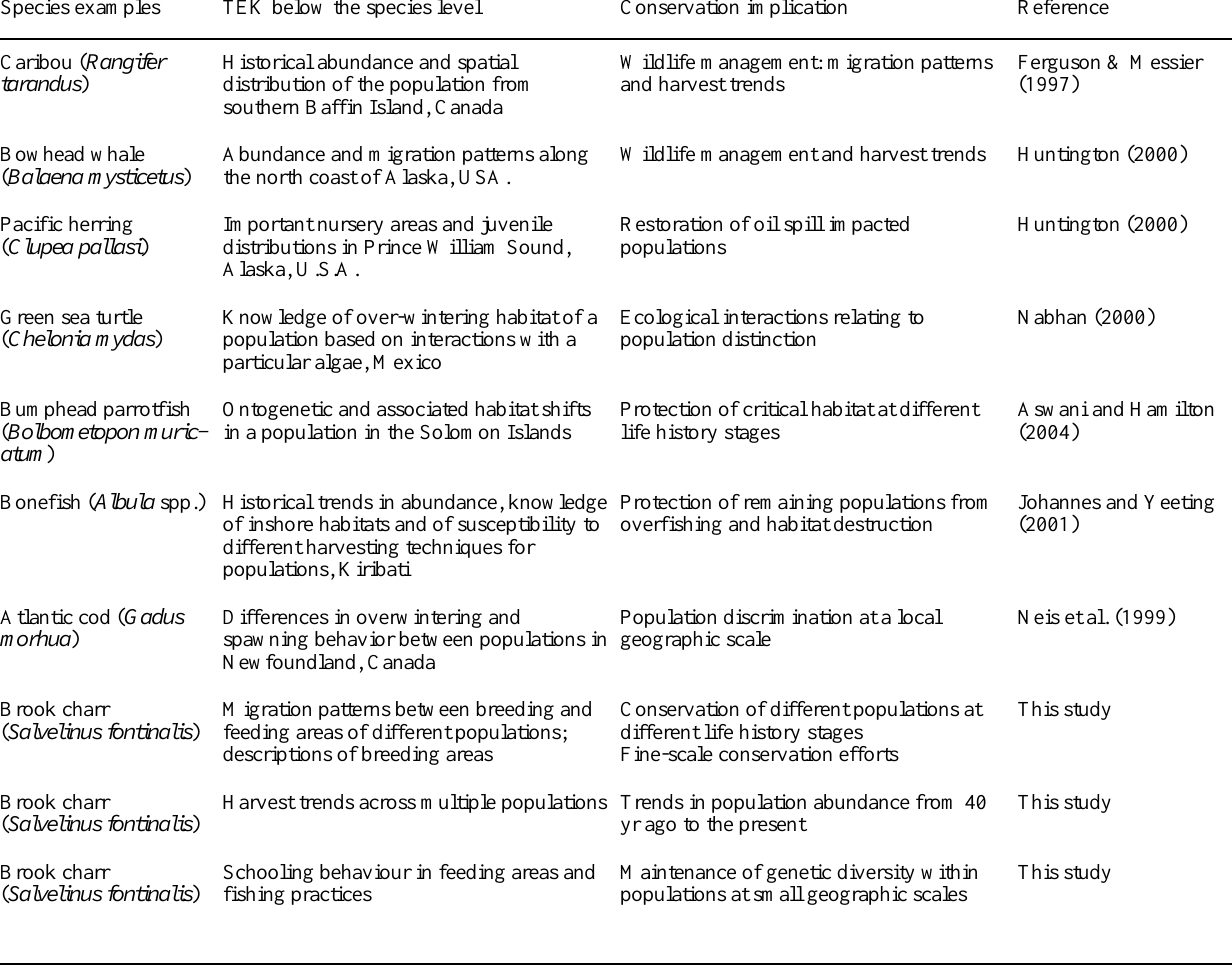
Table 1. Examples of traditional ecological knowledge (TEK) used in conservation planning below the species